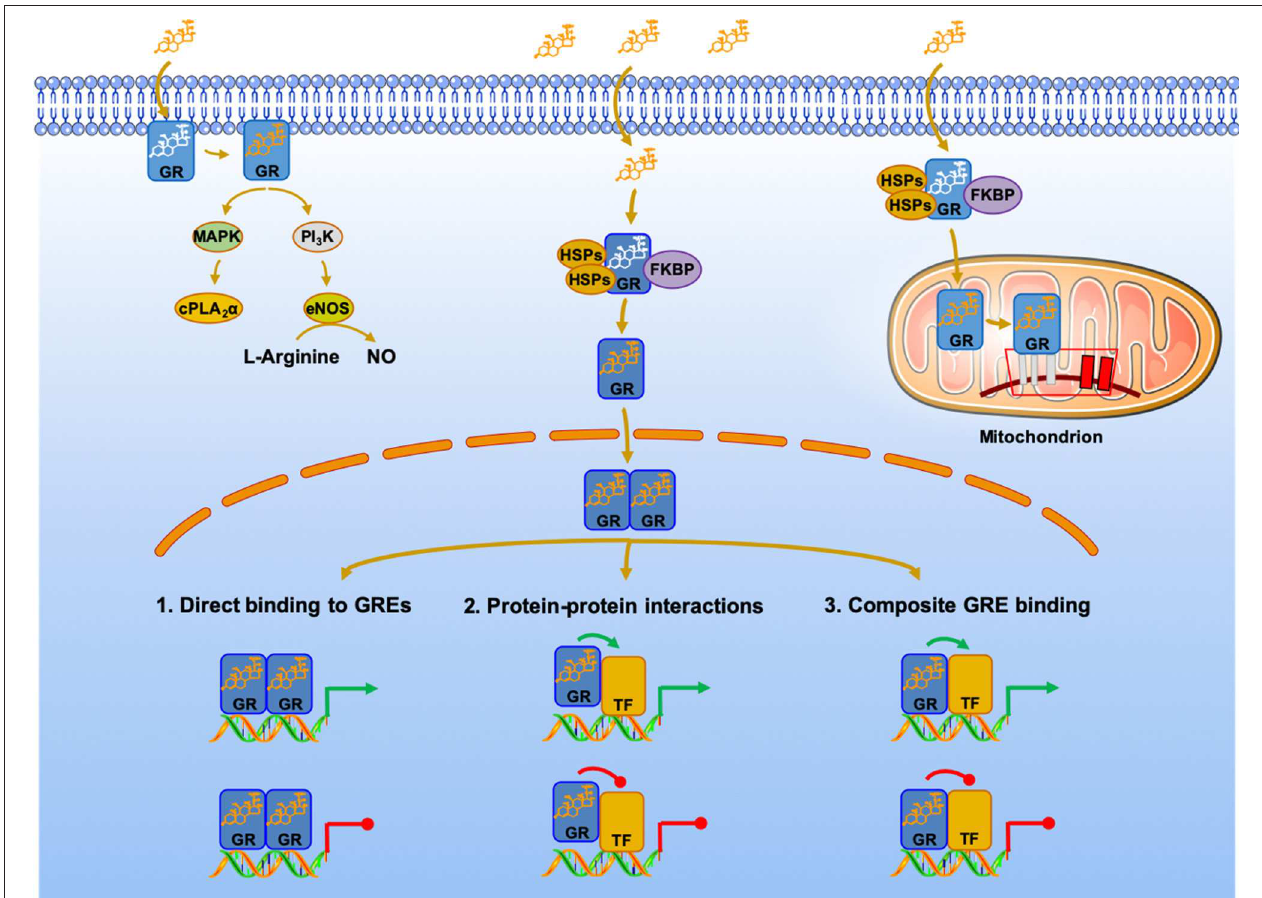
FIGURE 2 | Genomic, non-genomic, and mitochondrial glucocorticoid signaling pathways. Glucocorticoid receptor mechanisms of action. The classic actions of GR α are shown in the middle of the panel. The dormant but ligand-friendly receptor, located in the cytoplasm, is bound to co-chaperon molecules, such as heat-shock proteins and the immunophilin FKBP. Upon binding to the ligand, the activated receptor translocates into the nucleus, where it interacts with GREs and/or other transcription factors, such as NF- κ B and AP1, to regulate the activity of glucocorticoid-responsive genes, which represent ∼ 20% of the human genome. In addition, cell membrane-associated GR α may be activated by the MAPK and PI3K kinases, as shown in the left of the panel. In addition, by as yet unknown mechanism, the GR α translocates into the mitochondria, where it interacts with the mitochondrial DNA GREs, regulating the activity of mitochondrial genes. See text for additional details cPLA2 α , cytosolic phospholipase A2 alpha; eNOS, endothelial nitric oxide synthetase; FKBP, immunophilins; GR, glucocorticoid receptor; HSP, heat shock proteins; MAPK, mitogen-activated protein kinases; NO, nitric oxide; PI3K, phosphatidylinositol 3-kinase; TF, transcription